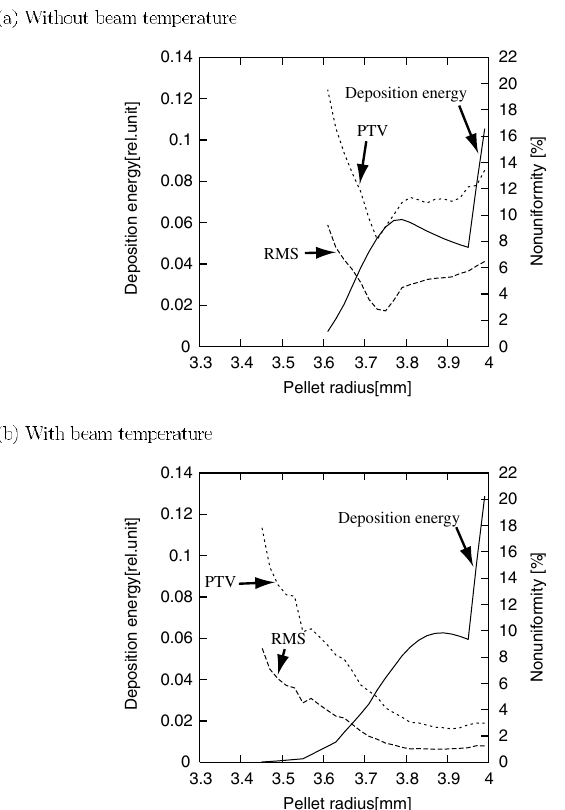
FIG. 7. The deposition energy of beam particles in the rela- tive unit and nonuniformities at each surface in the cases (a) without the beam temperature effect and (b) with the tempera- ture effect for the Pb (cid:1) Al layer target for the chamber radius of 5 m, 120-beam system, and the semi-Gaussian